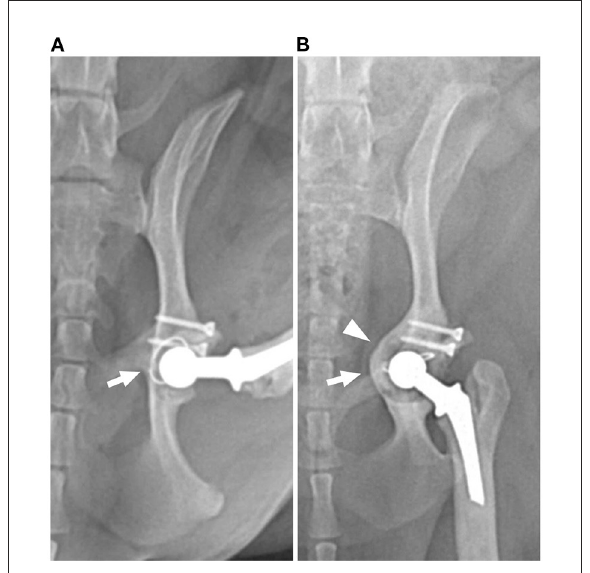
FIGURE1 Postoperative ventrodorsal radiographs of the left hip showing evidence of loosening with rotation (arrow) and medialization (arrowhead) of the acetabulum and cemented cup implant. (A) Immediately and (B) 16-month postoperative radiographs.